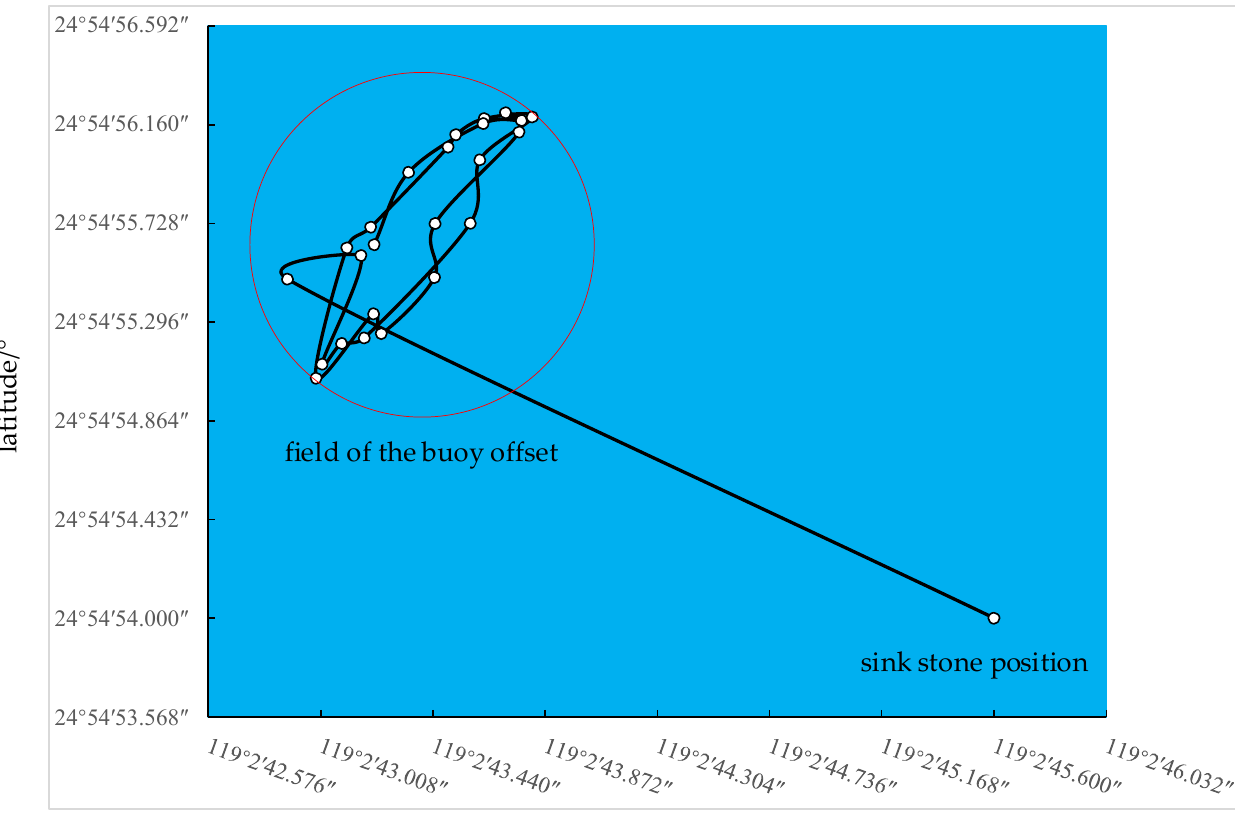
The multiplication seasonal model is used as the prediction model to predict the future offset position, and then the predicted offset trajectory is made according to the predicted offset value of the next 24 h. According to Formula (7), the parameter m of the buoy offset field is calculated, and the buoy offset field is made. Figure 21 is used to calculate the buoy field parameter m = 46.8, and the center coordinate of the buoy offset field is